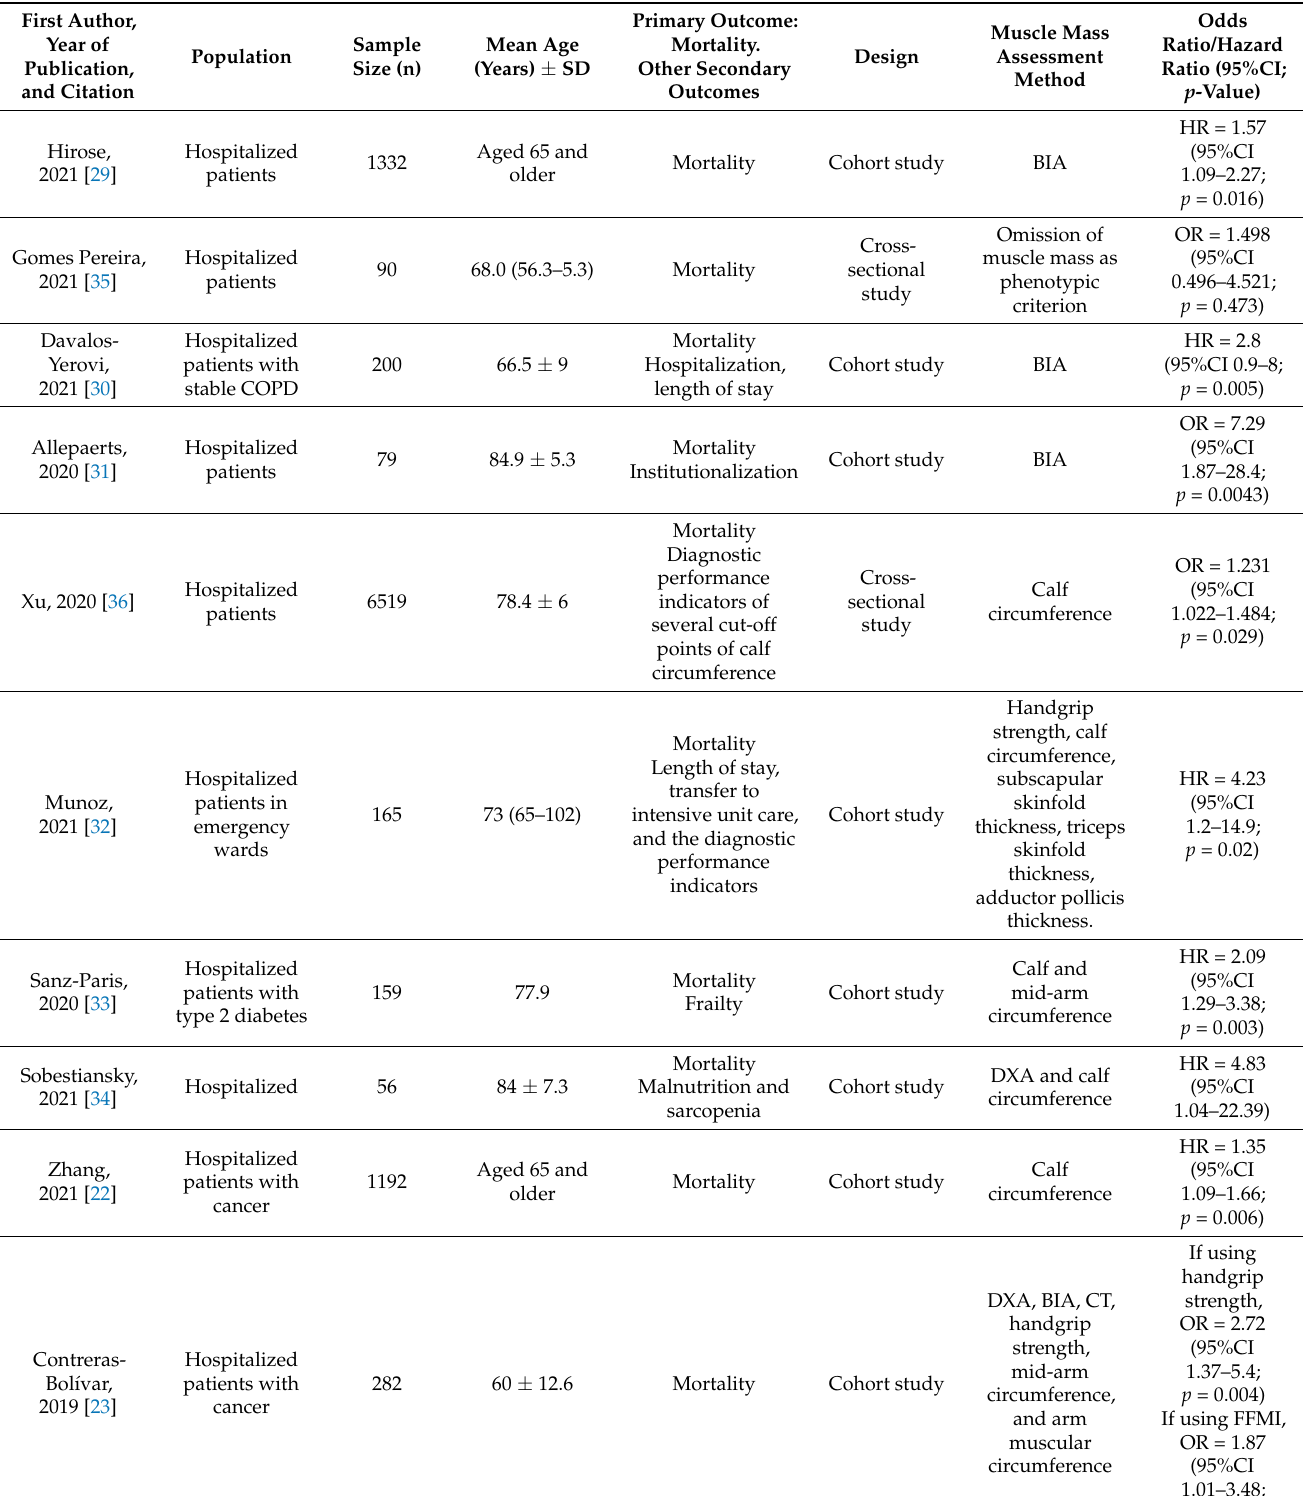
Table 2. Summary of findings from the bibliographic search (from 1 September 2018 to 1 January 2023) of the scoping review, ordered according to the three populations assessed (hospitalized, community- dwelling, and nursing home older populations) (n =